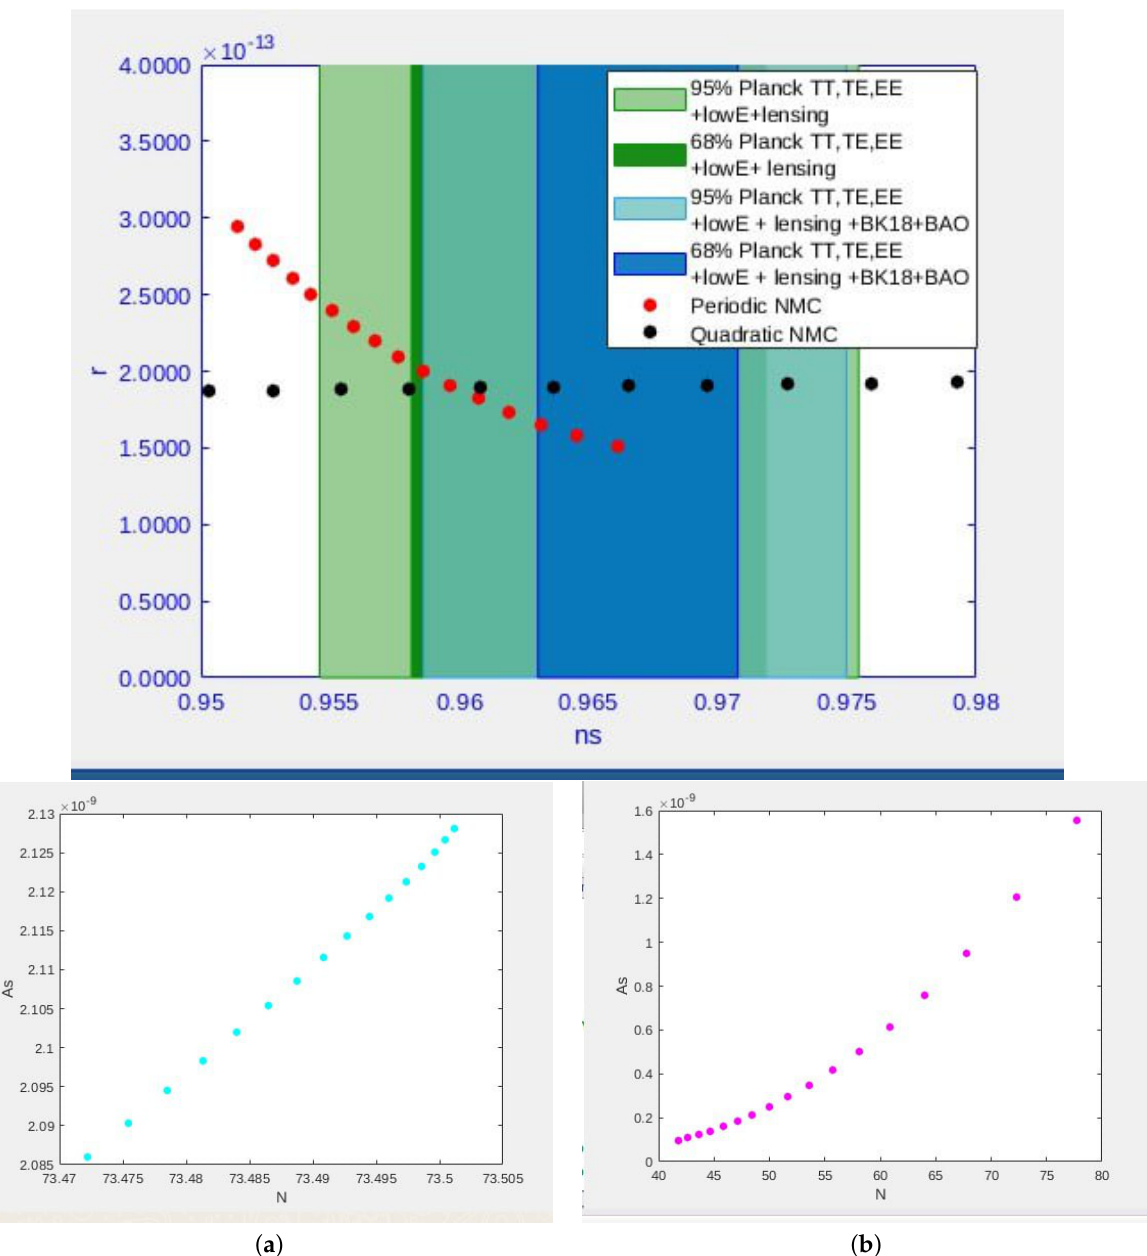
Figure 4. Above: Cubic dissipation case for both quadratic and periodic NMC, showing consistency with observational data regarding ( n s , r ). Bottom: The quadratic NMC ( a ) accommodates ( A s , N e ), whereas the periodic ( b ) NMC accommodates N e and the magnitude order of A s